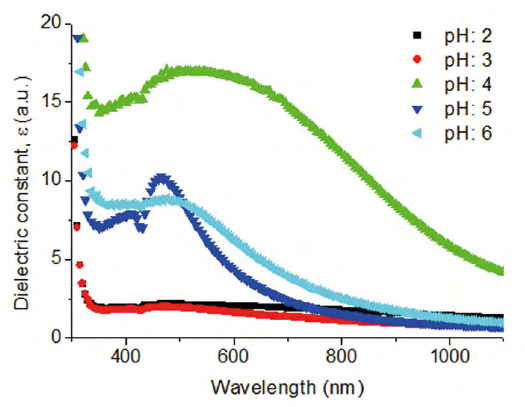
Figure 6. Optical transmission and reflectance spectra of AgI thin films grown at different pH values of the chemical bath.